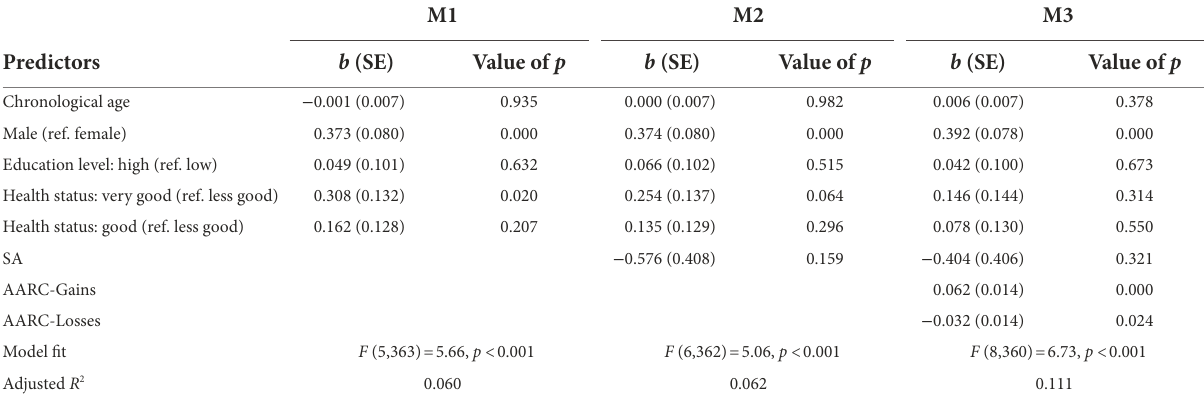
TABLE 3 Stepwise linear regression analyses to predict STAI.